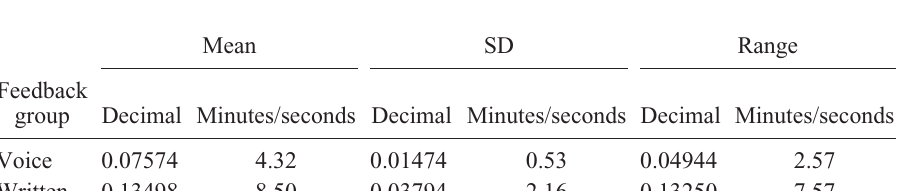
Table 9. Time requirements for delivering voice and written